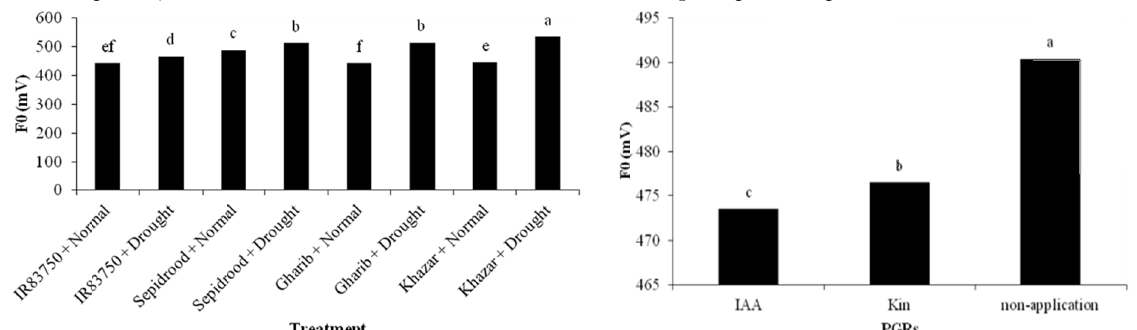
Fig. 1. Effects of the treatments on day to leaf rolling (means in each different, using Tukey Test. IAA: Indole-3-Acetic Acid, Kin: Kinetin, PGR: plant growth regulator)